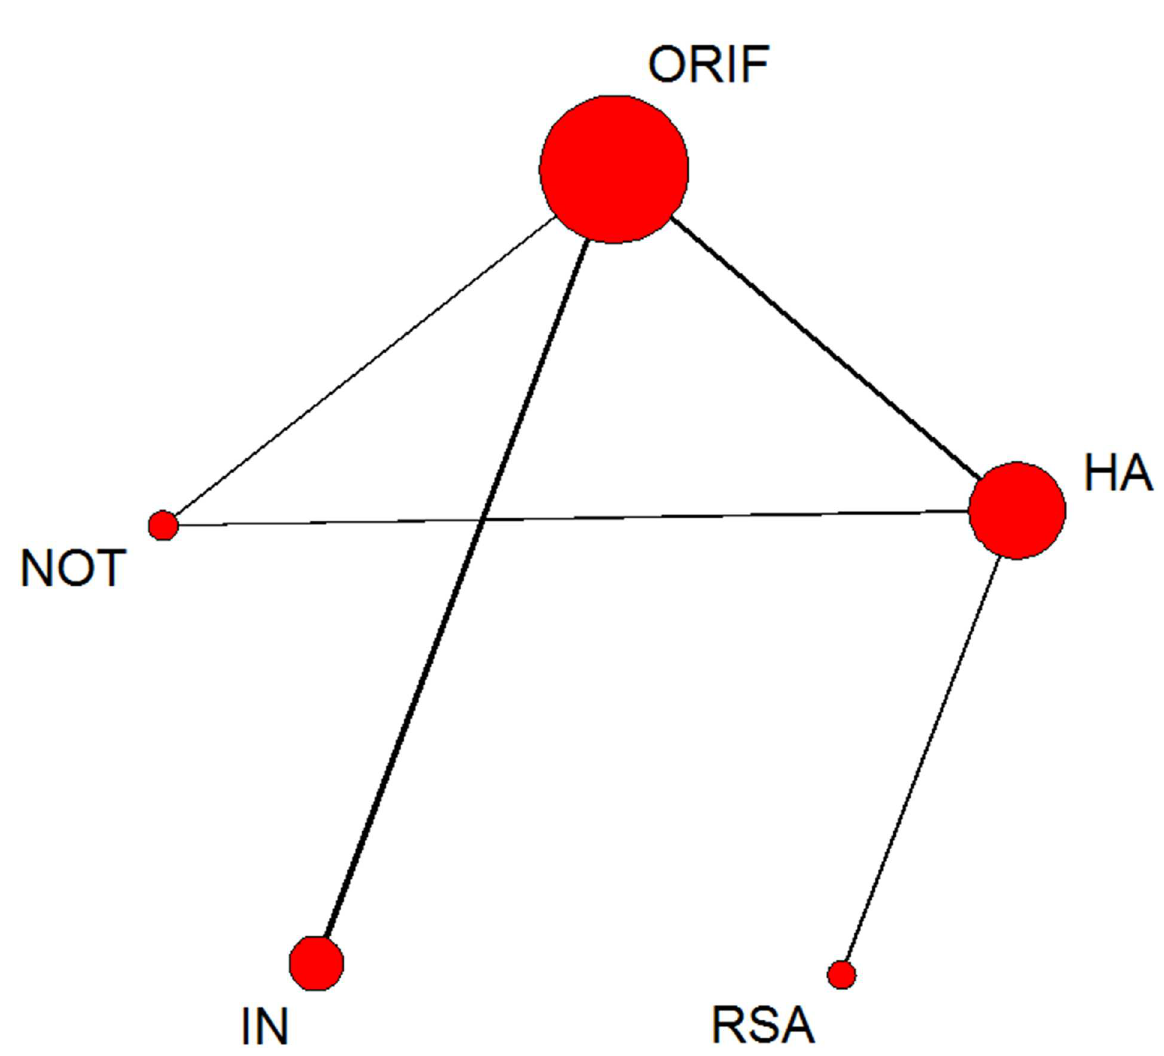
Fig 5. Network of treatment comparisons for incidence of total complications. The size of the node correspondsto the total sample size of treatments. Directly comparable treatments are linked with a line, the thickness of which represents the numberof trials that were compared. ORIF: open reduction and internalfixation; HA: hemiarthroplasty; RSA: reverse shoulderarthroplasty; IN: intramedullary nailing;NOT: Non-operative treatment.